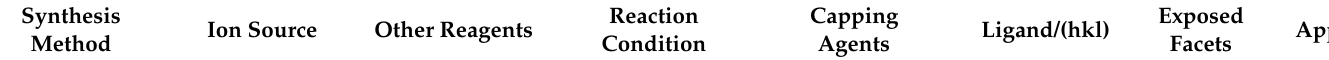
Table 3. Comparison of synthesis methods and application of various facet-dependent TiO